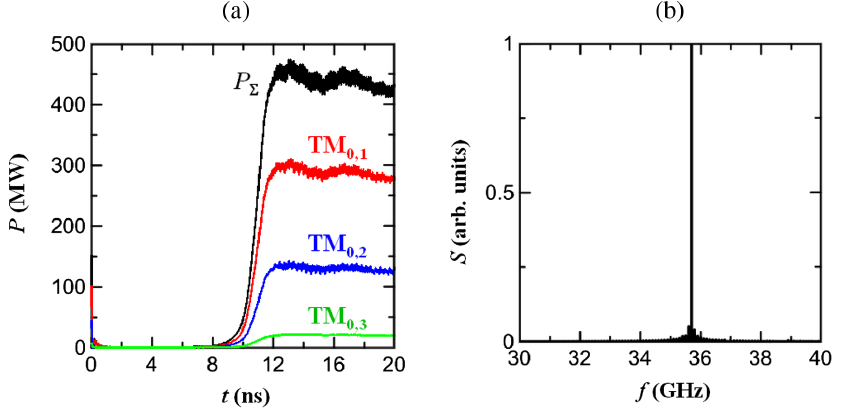
FIG. 11. CST PIC simulations of sub-GW Ka-band 2D SWOs based on the high-current accelerator SINUS-6: (a) Time dependence of the total output power P Σ and partial powers associated with various azimuthally symmetric modes and (b) radiation spectrum S in the steady-state generation regime.